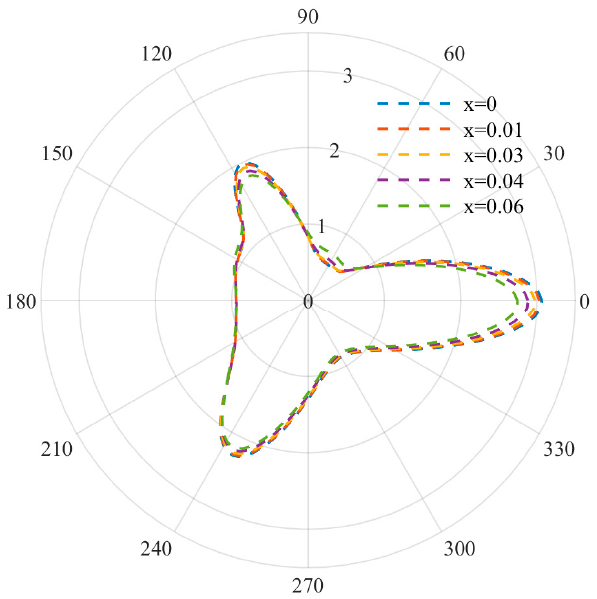
Figure 5. Distribution diagram of DSCD ( ka = 1.2).